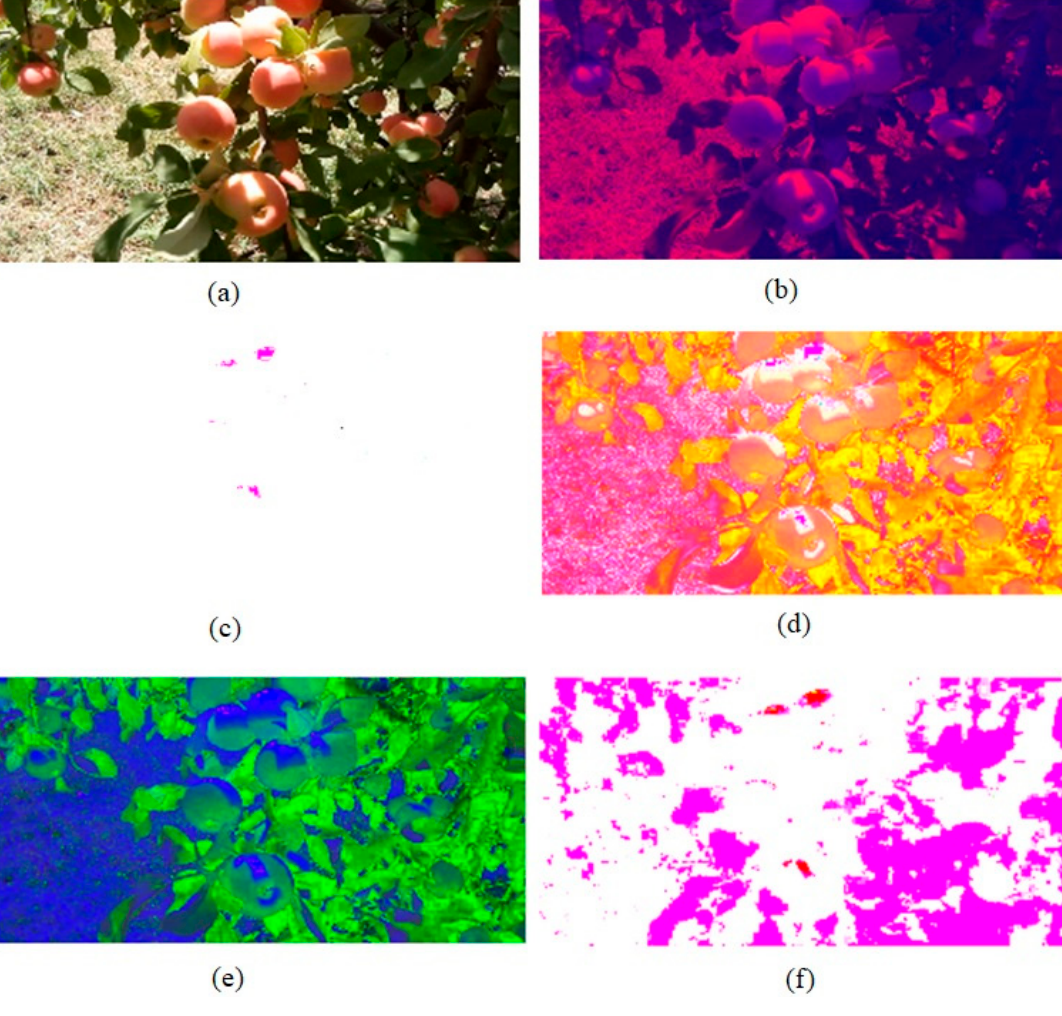
Figure 2. Sample image in six different color models. ( a ): RGB color model, ( b ): Improvement YCbCr color model, ( c ): LCH color model, ( d ): HSL color model, ( e ): HSI color model, ( f ): Luv color model.